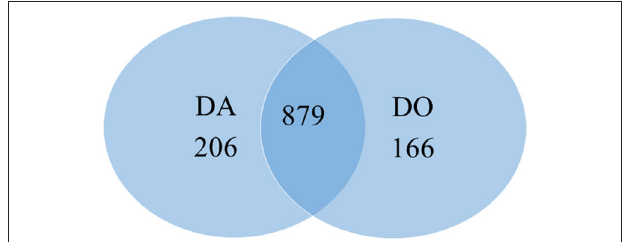
FIGURE 2 | Venn diagram totaling the number of proteins similarly and differently regulated in heart-shaped gametophytes from the apomictic fern Dryopteris affinis (DA), and its sexual relative D. oreades